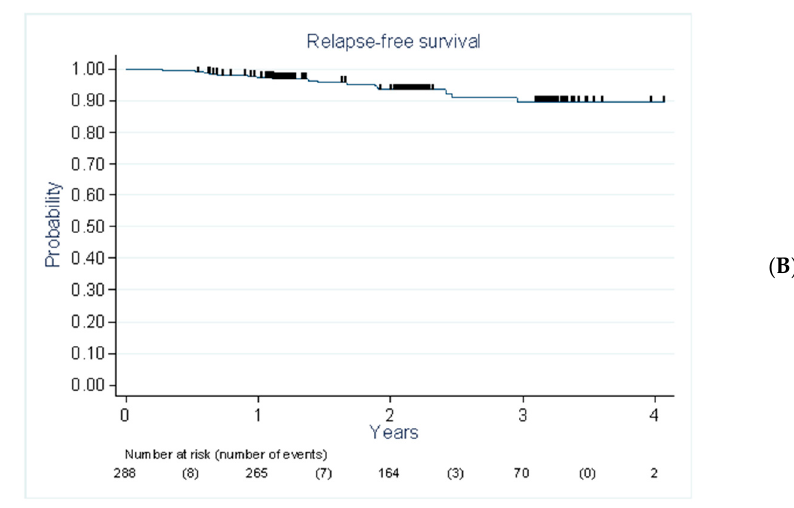
Figure 2. Overall survival ( A ) and disease-free survival ( B ) according to the Kaplan–Meier method (breast-conserving surgery).